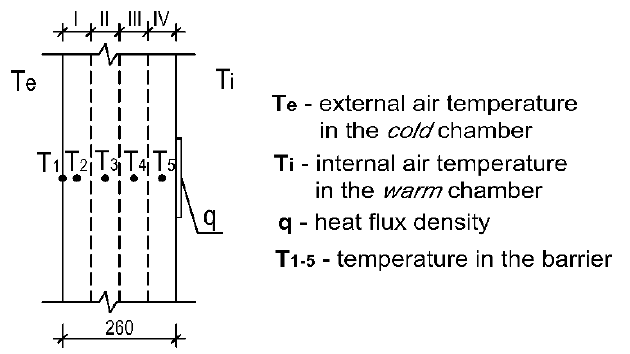
Figure 3. Diagram of the partition with temperature and heat flux density sensors.